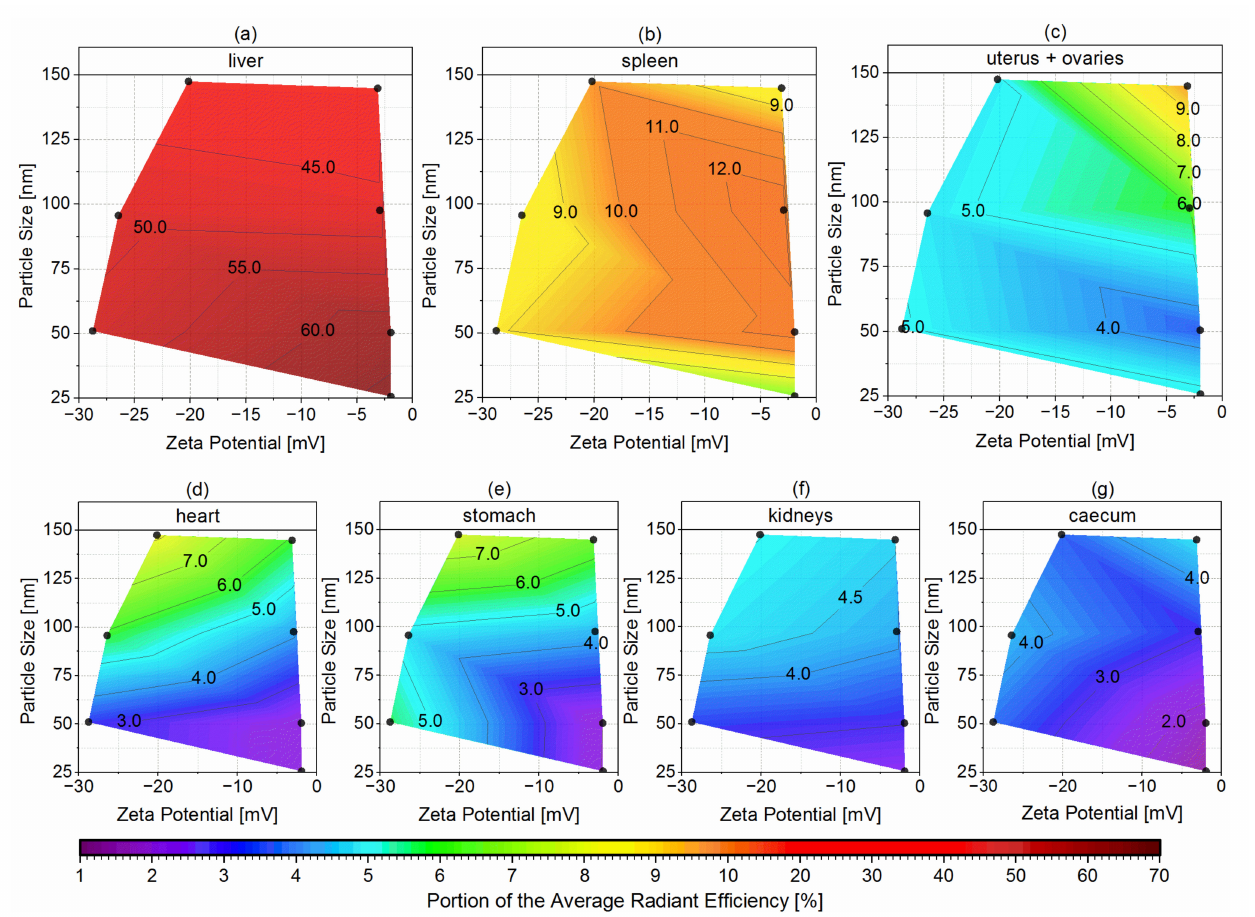
Figure 11. Logarithmic contour plots of the mean PARE for the organs with the highest accumula- tions (( a ) liver, ( b ) spleen, ( c ) uterus + ovaries, ( d ) heart, ( e ) stomach, ( f ) kidneys, and ( g ) caecum) plotted against the particle size and the zeta potential of the three i.v. injected negatively surface- nanoemulsions [24], displayed as •